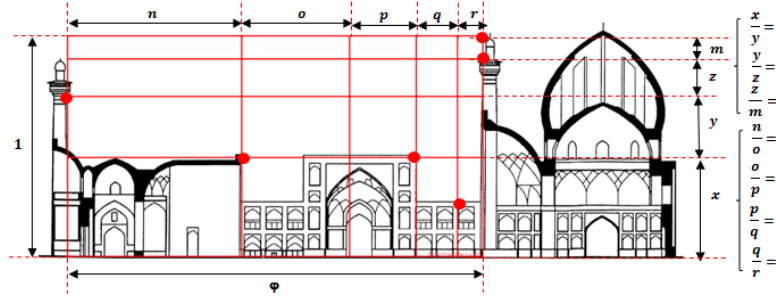
Figure 11: Abstract frame between two finials (left-side of north-south section) adapt with Golden rectangle